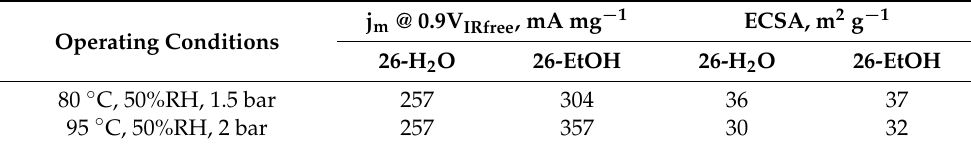
Table 2. Electro-kinetic parameters for MEAs with different dispersing agents.